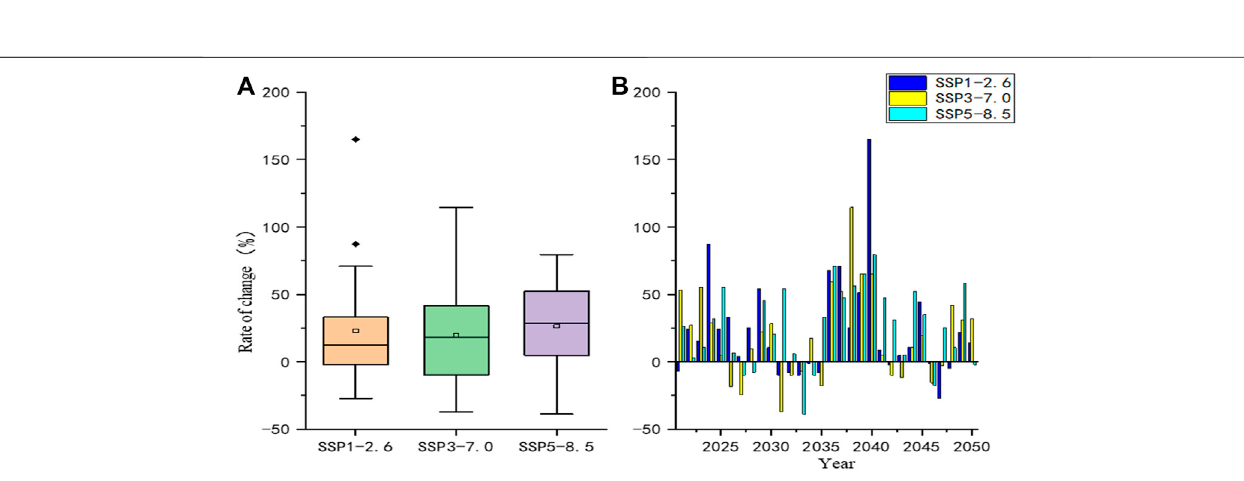
Frontiers in Environmental Science |